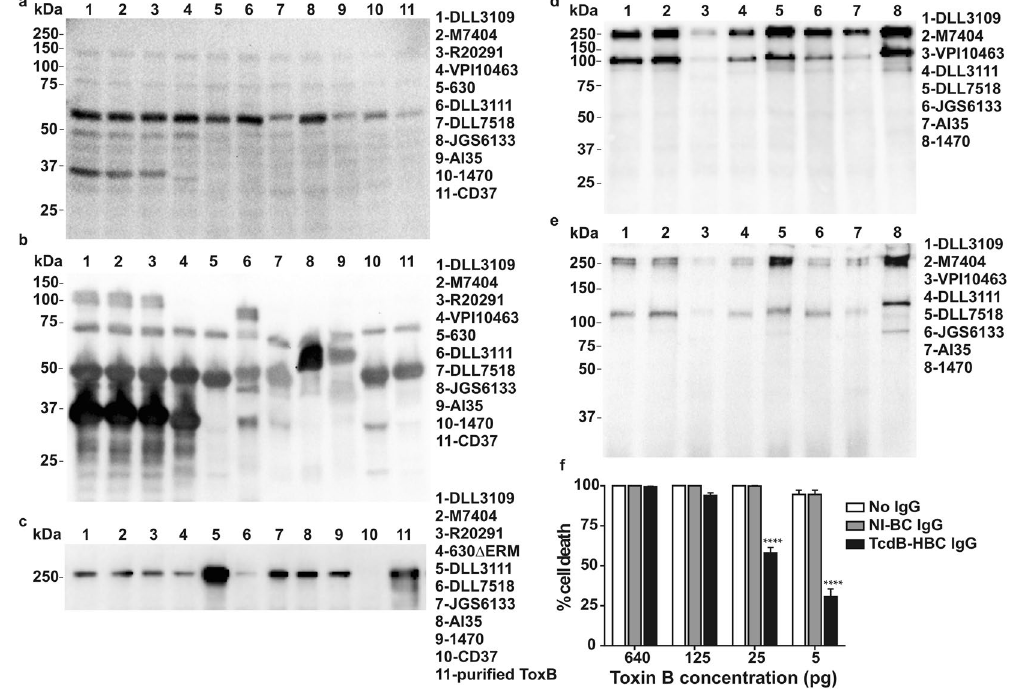
Figure 2. C. difficile -specific antibodies in colostrum are cross-reactive and able to neutralise the cytotoxicity of TcdB. C. difficile whole cell lysates from a variety of strains were used to detect vegetative cell-specific IgG purified from Veg-HBC ( a ) or SLP-HBC ( b ), respectively. Crude toxin preparations from the panel of strains indicated were used to detect TcdB-specific IgG purified from TcdB-HBC; control lanes contained purified TcdB from an 027 strain (tgcBIOMICS; Lane 11) while a non-toxigenic strain (CD37) was used to show that binding was toxin-specific (Lane 10) ( c ). Exosporium proteins isolated from a variety of clinical and animal isolates of C. difficile were used to detect spore-specific IgG purified from Spore-HBC ( d ) or Exo-HBC ( e ), respectively. C. difficile strains used are indicated alongside each panel ( a – e ). To determine if TcdB-HBC contained IgG capable of neutralising TcdB, purified TcdB from strain VPI10463 (Abcam) was incubated for 60 minutes with either PBS, NI-BC IgG or TcdB-HBC IgG before being added to Vero cell monolayers. After a 24 hour incubation, the percentage of cell death was determined by directly visualising cells for cell rounding ( f ). The experiment was performed in triplicate. Data represent the mean ± SEM and statistical significance was assessed using a two- way ANOVA with a post hoc Bonferroni multiple comparison test. **** Indicates P <